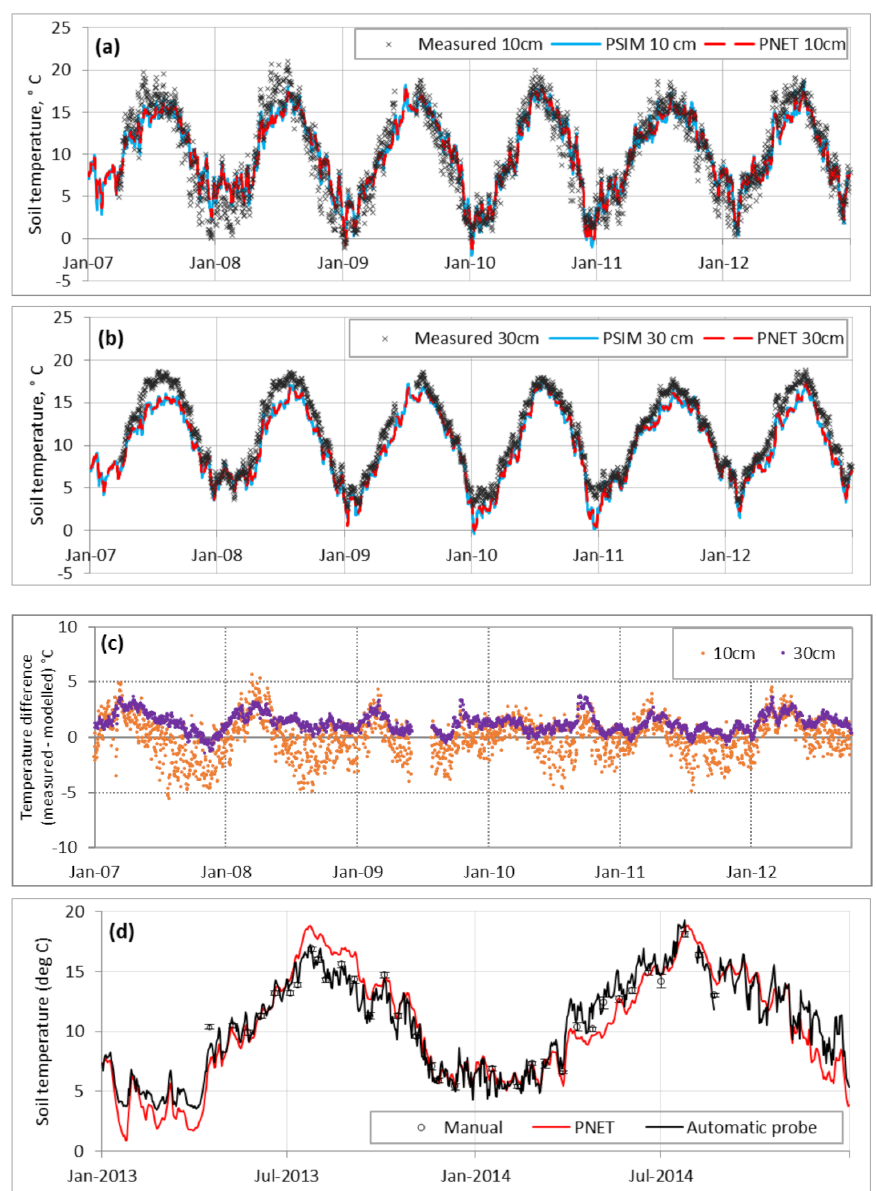
Figure 1. Daily mean measured and simulated soil temperature for years 2007–2013 at the Straits Inclosure, Alice Holt Forest. Measured data are from a fixed automatic probe at the Tower Site. Scheme ( a ) temperatures at 10 cm soil depth, ( b ) temperatures at 30 cm soil depth, ( c ) residuals (measured–simulated with PnET) at 10 cm and 30 cm, ( d ) temperatures at 10 cm recorded manually and from fixed probe during 2013–2014 soil gas sampling. Error bars on manual measurements are 1 SD from 24 measurements made each